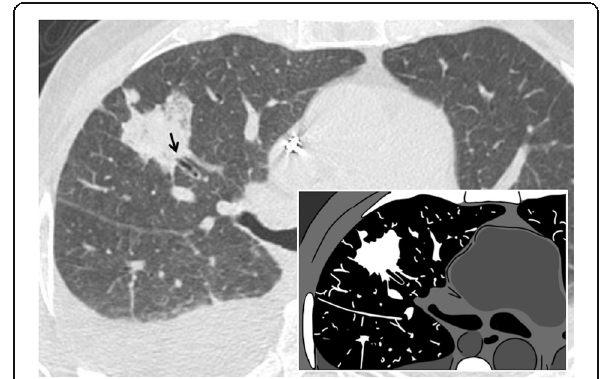
Fig. 27 Positive bronchus sign. The chest CT images and the embedded drawing demonstrate the positive bronchus sign: it consists of an air-filled bronchus (black arrow) — seen as a tubular hypo-attenuation area — oriented towards a peripheral nodular